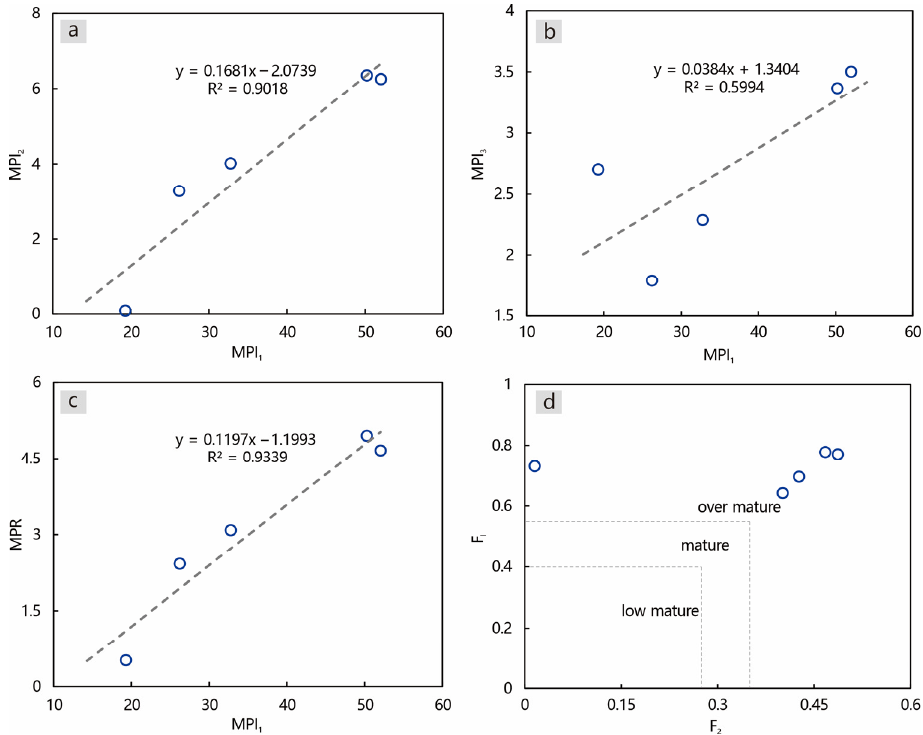
Figure 10. ( a – d ) Correlation diagram of maturity parameters of alkyl phenanthrene in bitumen from Qinglong paleo-oil reservoir.